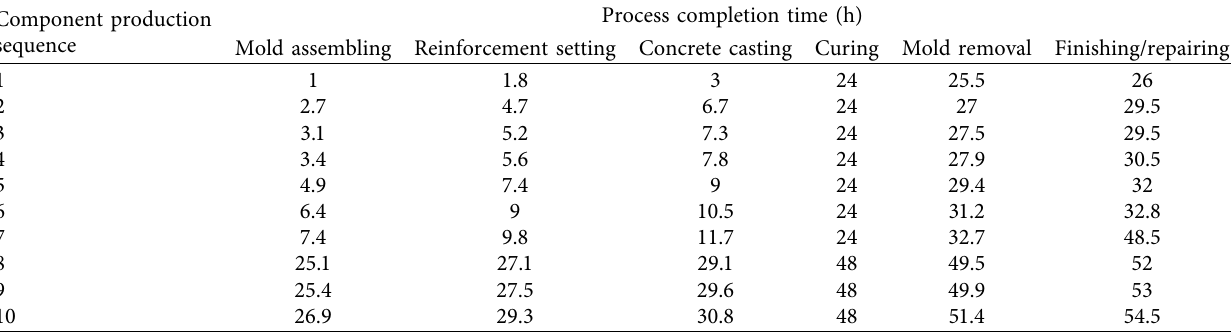
Table 5: Completion time of each process for scheme (1).